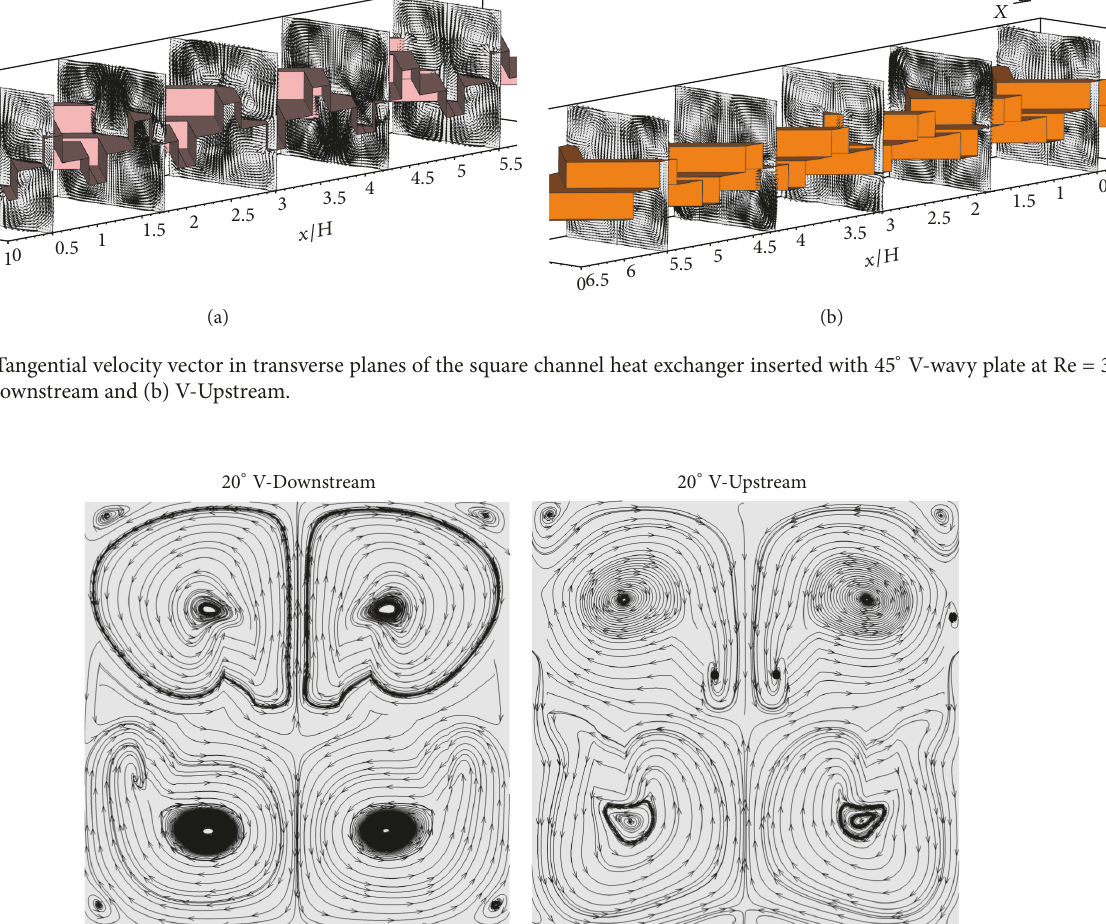
surface which is the cause of heat transfer